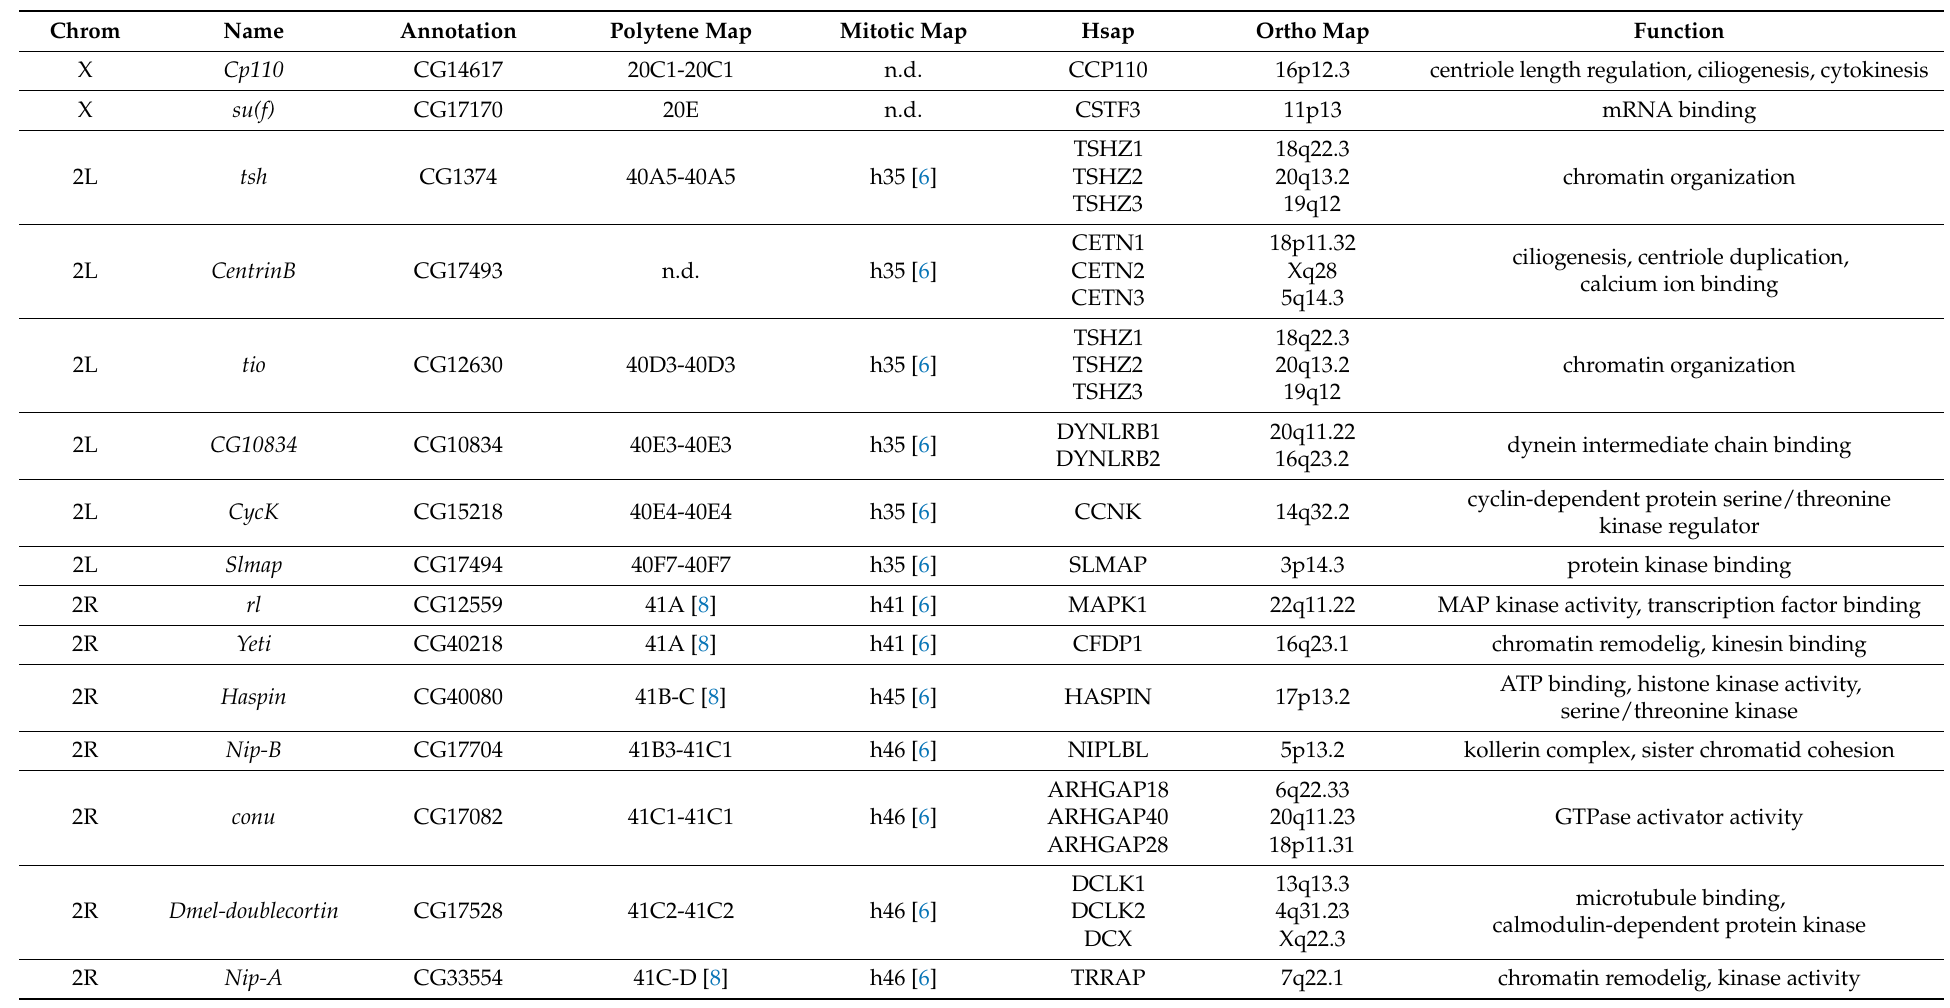
Table 1. List of the examined heterochromatic genes with their functions and cytogenetic and genomic locations. In this review, CG17493 and CG17528 were named CentrinB and Dmel-doublecortin, respectively (names not reported in FlyBase). Map positions as described in the HDGP project and FlyBase. Hsap = human orthologs; Ortho map = chromosome map of human orthologs; n.d. = not detected; n.a. = not